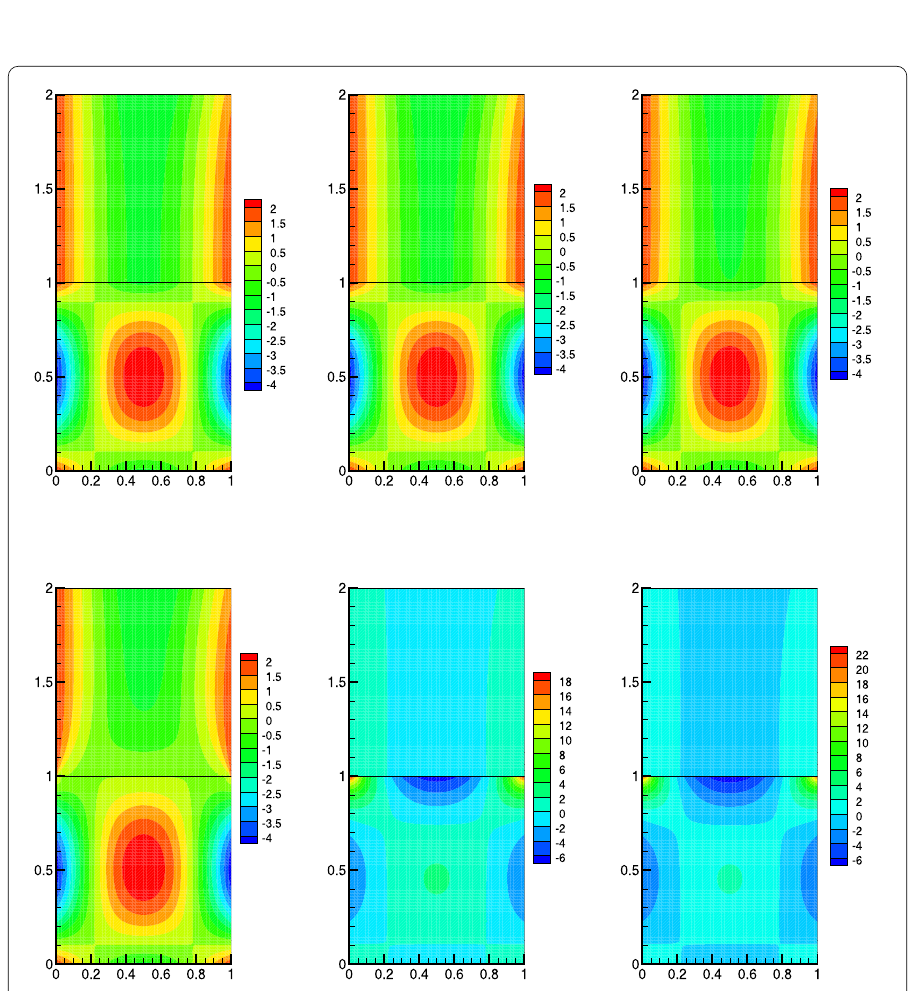
Figure 3 An illustration of the velocity contour with different values of the stabilization parameter for test 1: true solution (top-left); δ = 0.1 (top-middle); δ = 1 (top-right); δ = 1000 (down-left); δ = 0.0001 (down-middle); δ = 0